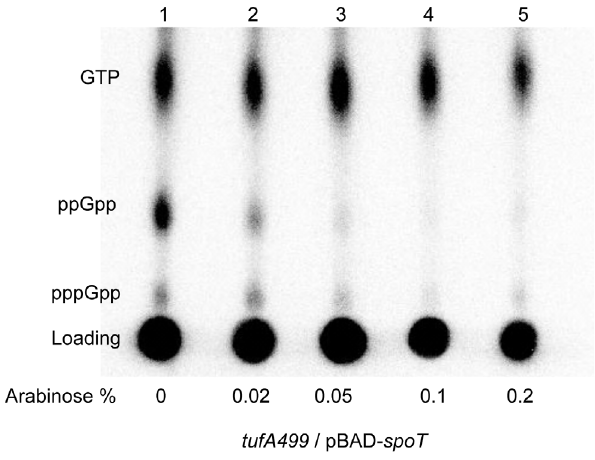
Figure 2. Reduction in ppGpp levels associated with induction of spoT overexpression. Thin layer chromatography of guanine nucleotides isolated from TH7964 ( tufA499 /pBAD- spoT ) grown with different concentrations of arabinose as indicated. The positions of ppGpp, pppGpp and GTP are indicated.